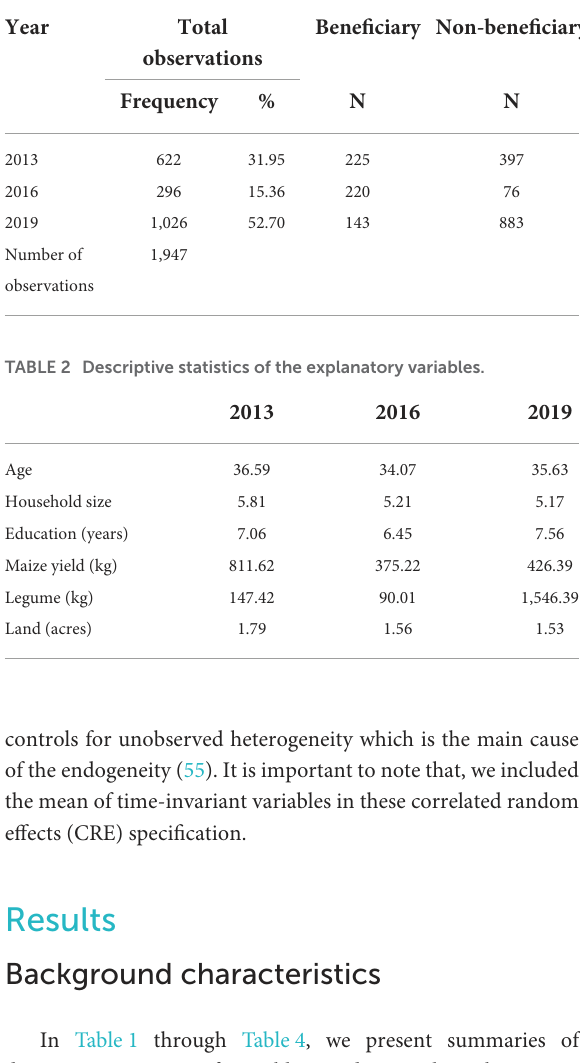
TABLE 1 Study sample of the 2013_2016_2019 panels.